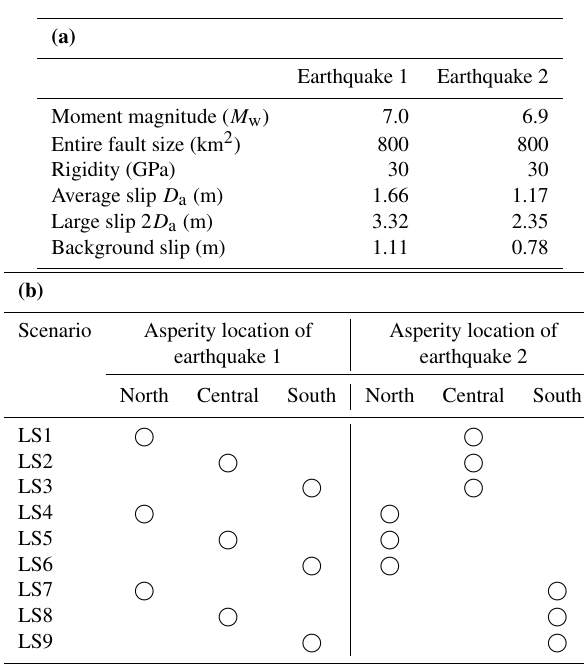
Table 4. (a) Details of the average slip, large slip, and background slip for the two earthquakes. (b) Asperity locations of multiple fault models for the two